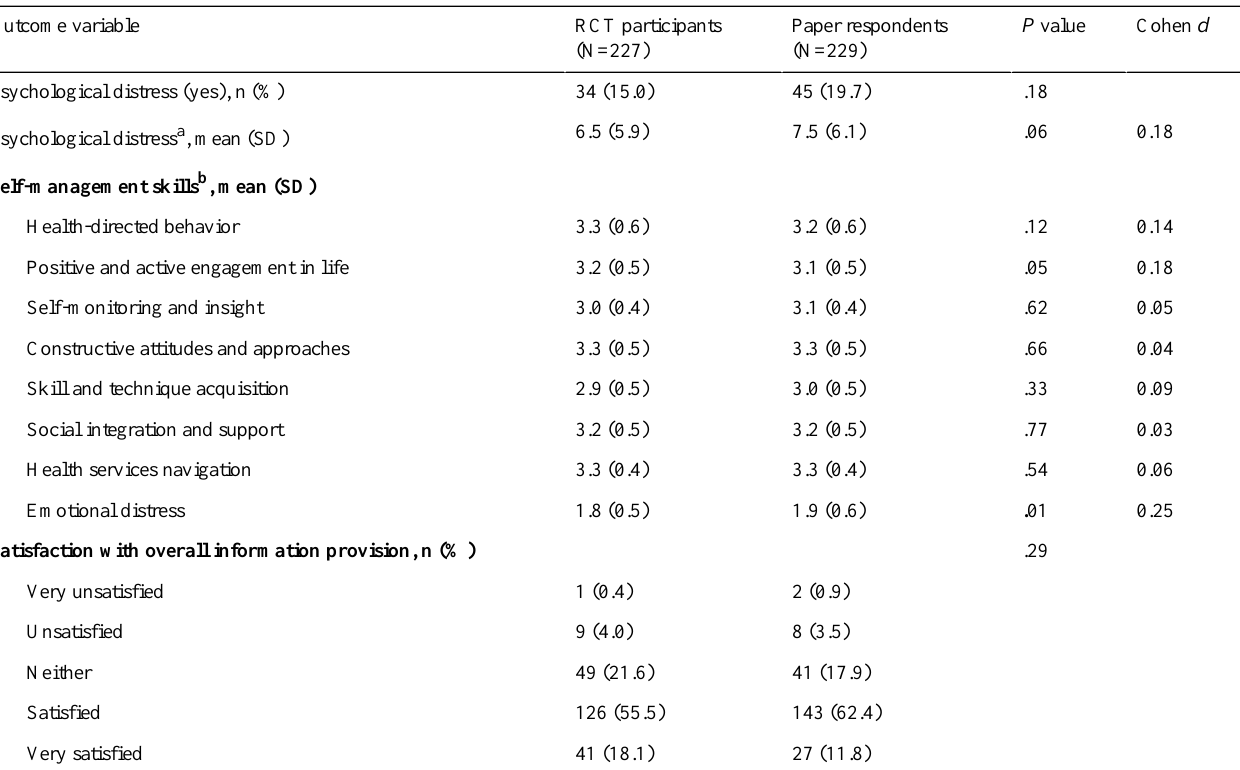
overall information provision (Table 2). Table 2. Differences in randomized controlled trial (RCT) outcome variables at baseline between RCT participants and paper